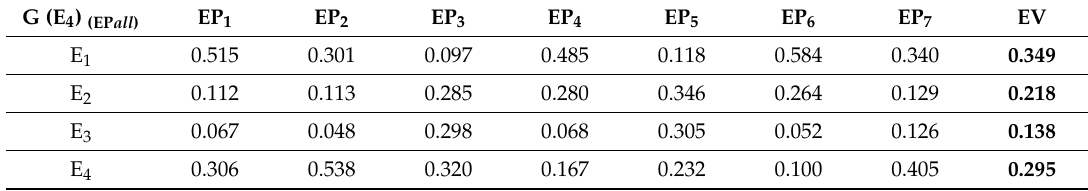
Table 5. Integrated EV values of P 1 , P 2 , P 3 and P 4 of the expert group targeting target G (E 4 ). G (E 4 ) (EP all